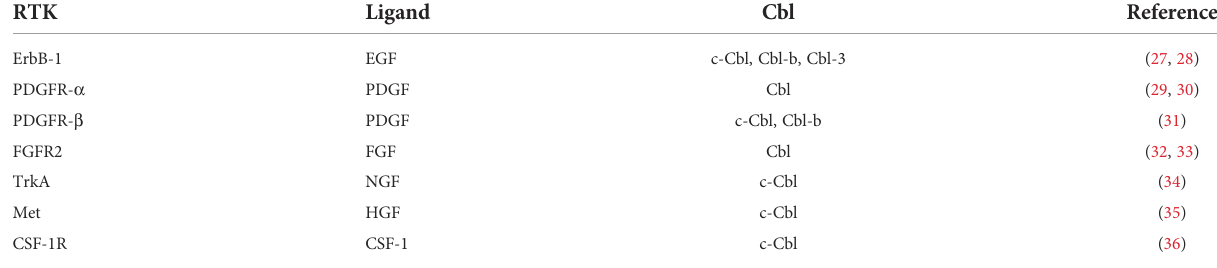
TABLE 1 Negative Regulation of RTKs by